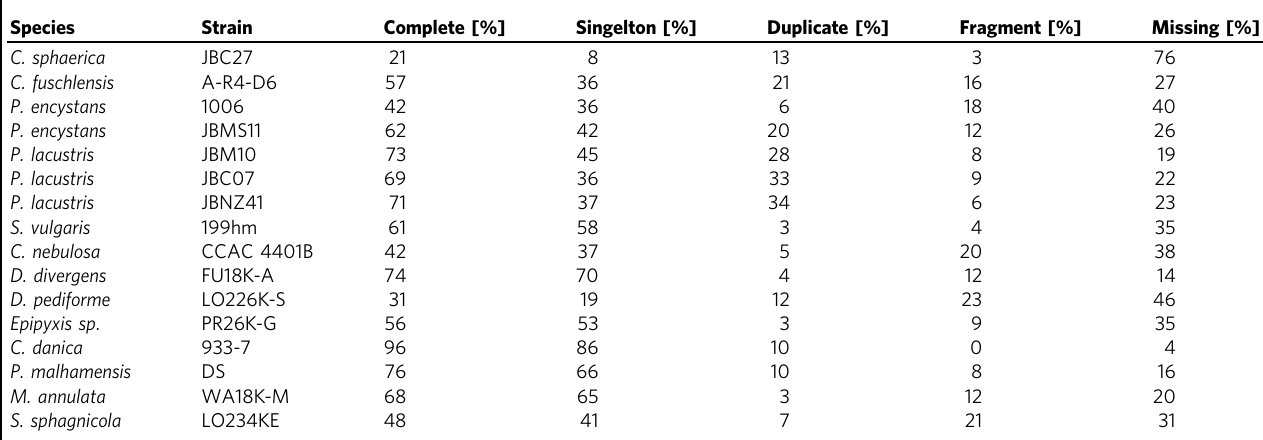
Table 3 BUSCO analysis results (protists set).